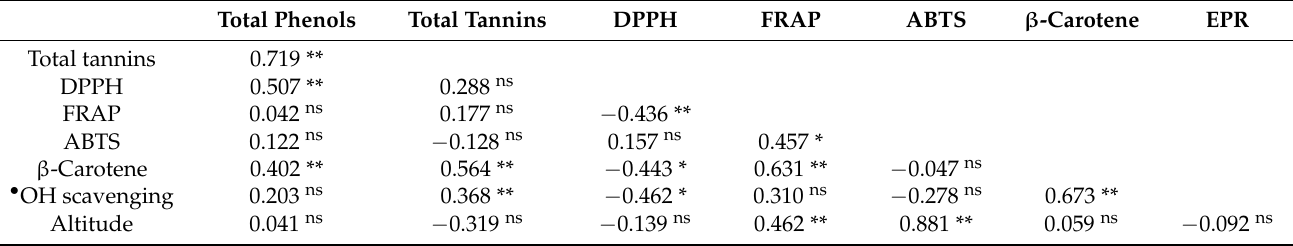
Table 7. Correlation coefficient (r) calculated between the phenolic compounds content analysed, antioxidant activity (AA) obtained with the different assays, developmental stages (DAF), and altitude in myrtle berries in leaf extracts. Significance: ** = p ≤ 0.01; * = p ≤ 0.05; ns = not